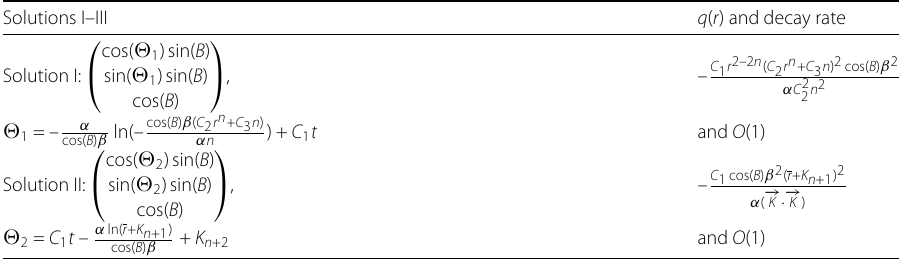
Table 1 Variable separation solution, inhomogeneity terms, and decay rate of ILLG equation (2) Solutions I–III